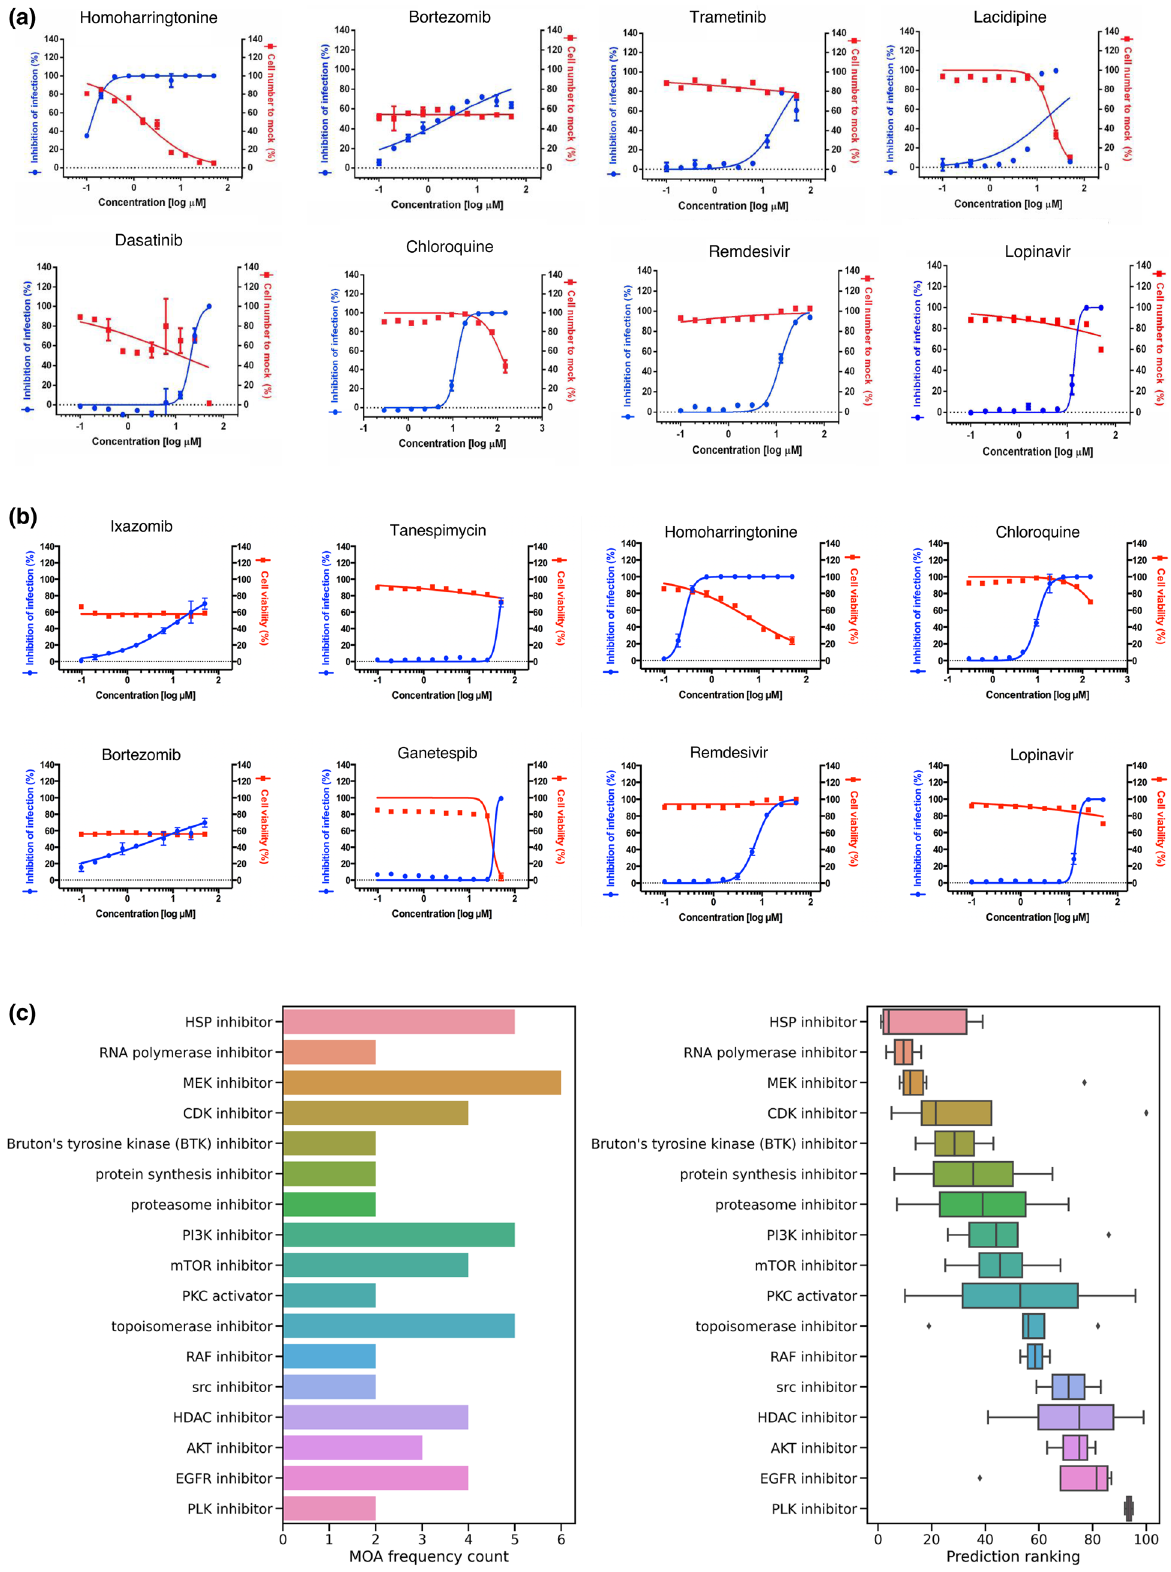
Figure 1. ( A ) Viral inhibition and cell viability curves used to generate Table 1 Round 1. ( B ) Viral inhibition and cell viability curves used to generate Table 1 Round 2. ( C ) Comparison of drug MOA class frequency count and predicted compound prediction ranking in Top 100 compounds with strongest predicted anti-viral